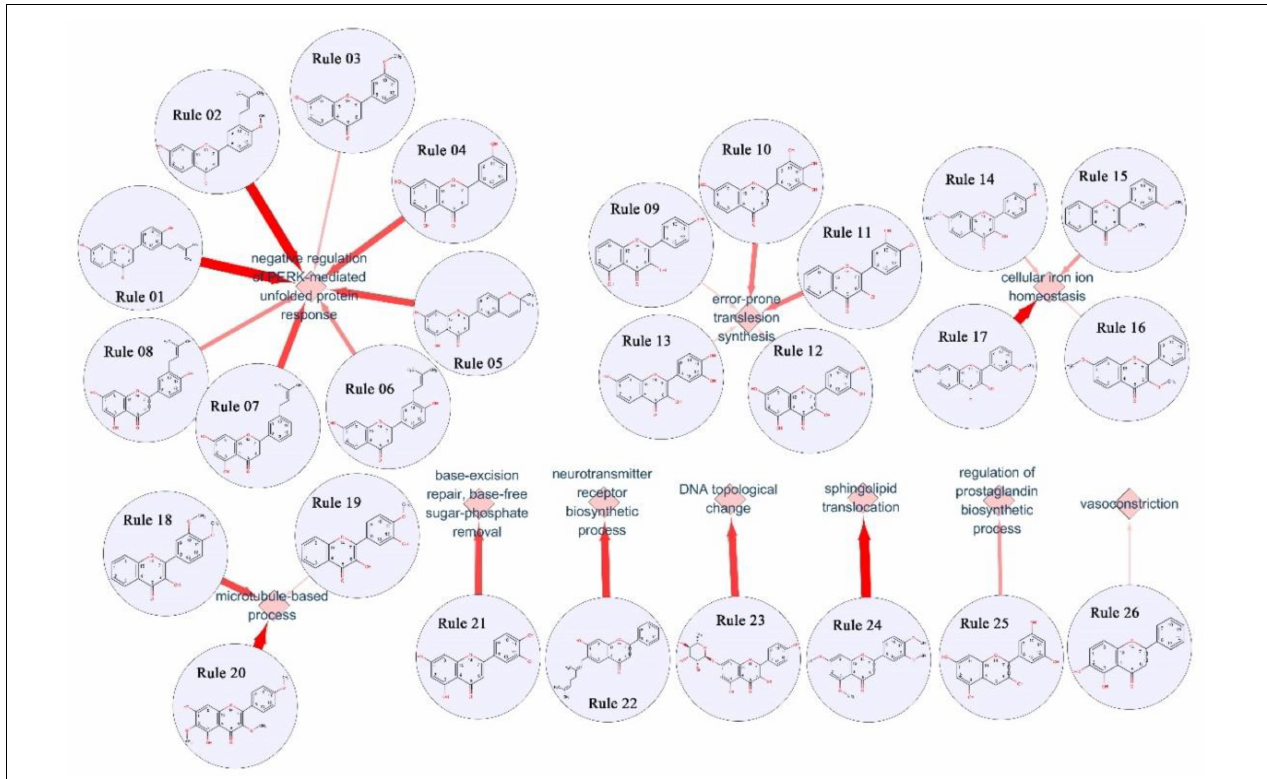
FIGURE 6 | Illustration of relationship between structure patterns and functions according to structure–activity relationship analysis of flavonoids.